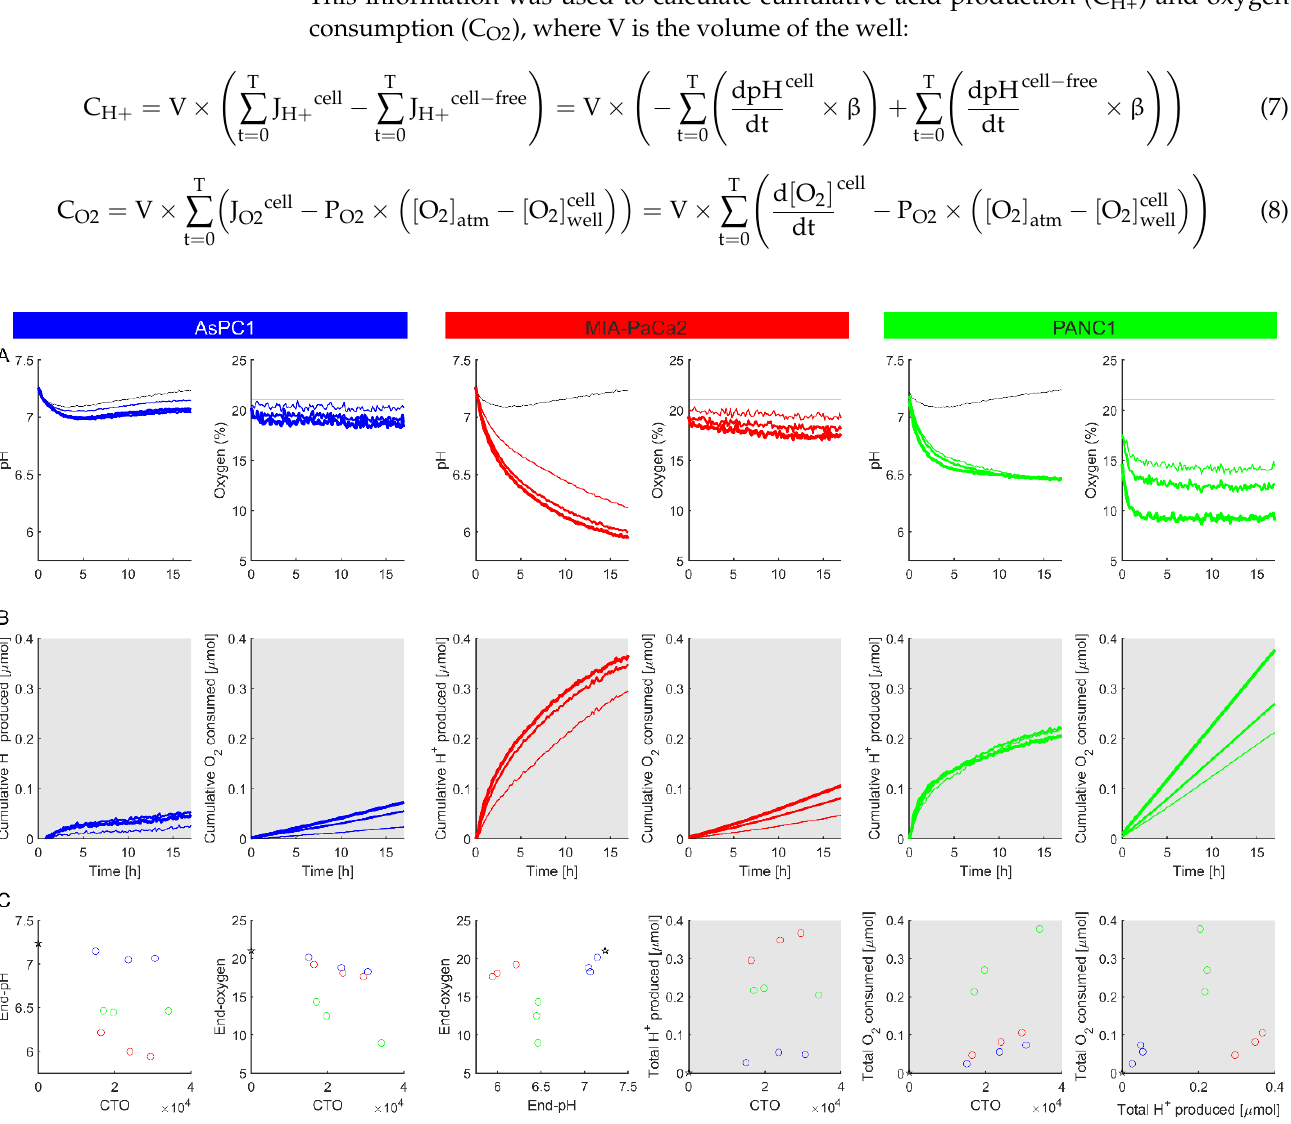
Figure 6. Metabolic profiling of PDAC cell lines. ( A ) Time courses of pH and O 2 for AsPC1 (blue), MIA-PaCa2 (red), and PANC1 (green) plated at 30, 50, or 70k cells per well. Thicker lines denote higher cell density. Blank time courses were obtained from cell-free wells. Media were prepared using DMEM 5030 and contained 2 mM HEPES and 2 mM MES, 25 mM glucose, supplemented with 10% FBS, 1% penicillin–streptomycin mixture. ( B ) Cumulative H + production and O 2 consumption, calculated using Equations (7) and (8). ( C ) Data from a and b replotted as a function of cell number, measured by CTO fluorescence. Plots with white background relate to end-point pH and O 2 , and plots with gray background relate to cumulative H + production and O 2 consumption. The black star symbol denotes data from cell-free wells. Plots represent a mean of 3 biological repeats.